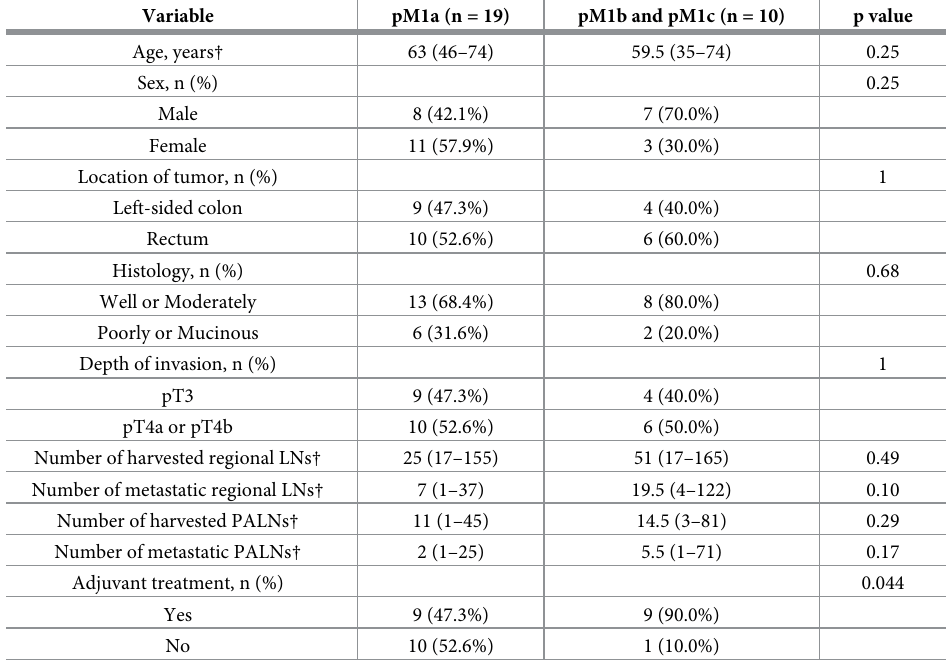
Table 3. Comparison of clinicopathological characteristics between the pM1a and pM1b/c.